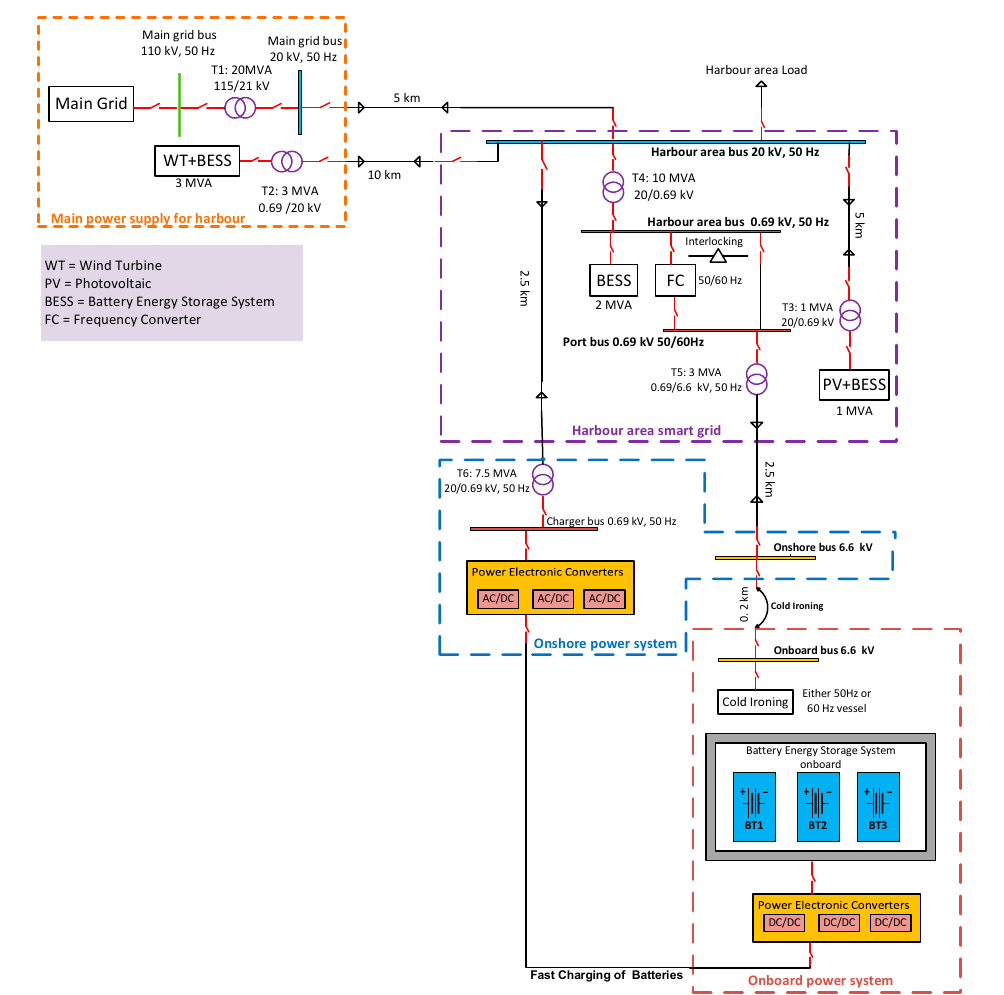
Figure 3. Configuration B: Fast charging of onboard batteries with a DC power supply from shoreside and cold-ironing with a separate connection.